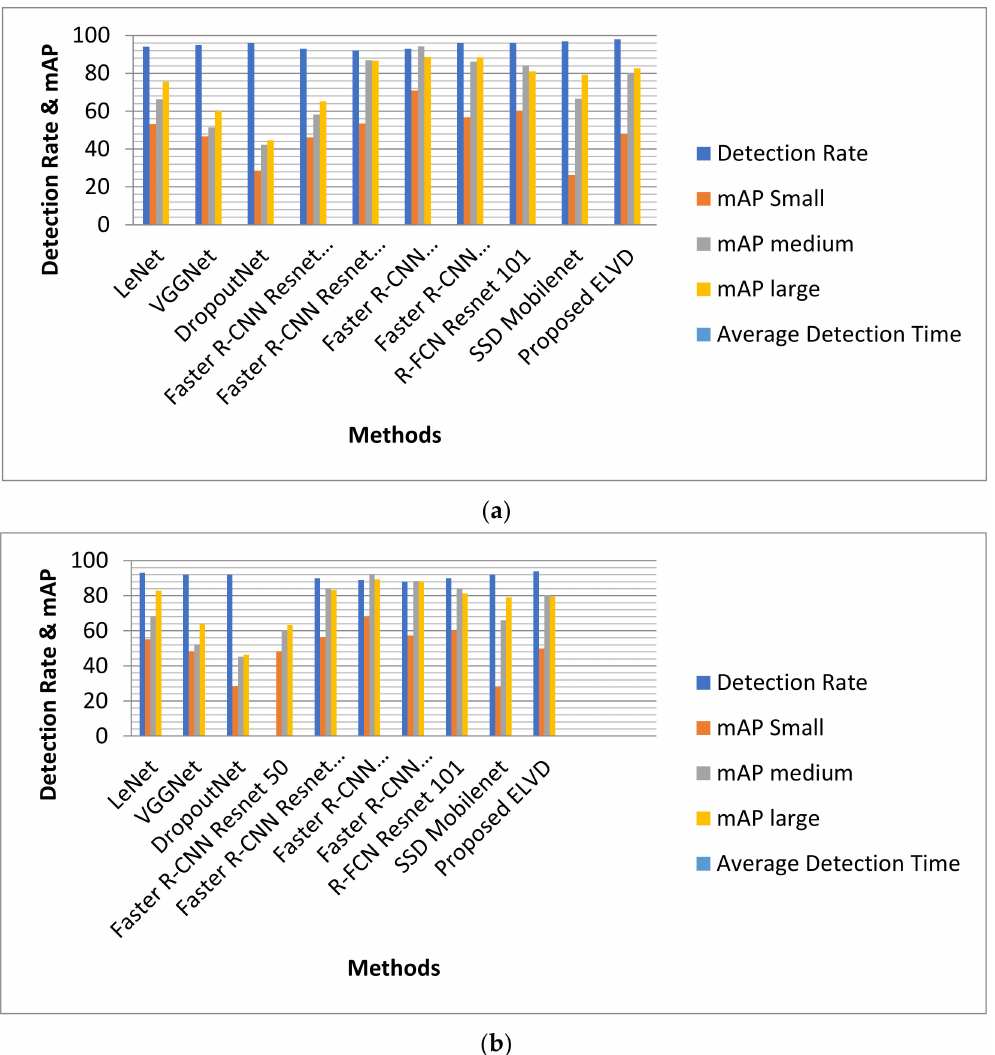
Figure 14. ( a ) Comparative Analysis with Existing Methods for the GTRSB dataset. ( b ) Comparative Analysis with Existing Methods for the TSRD